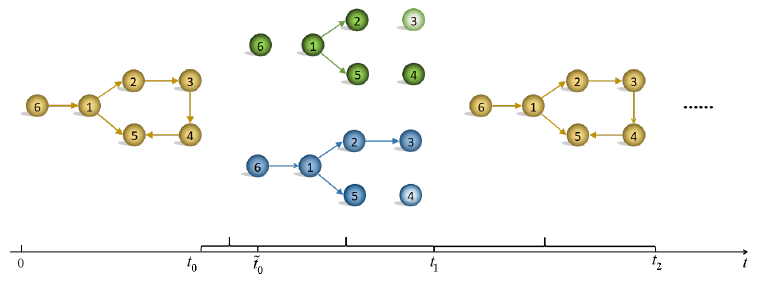
Figure 1. The evolution of DoS